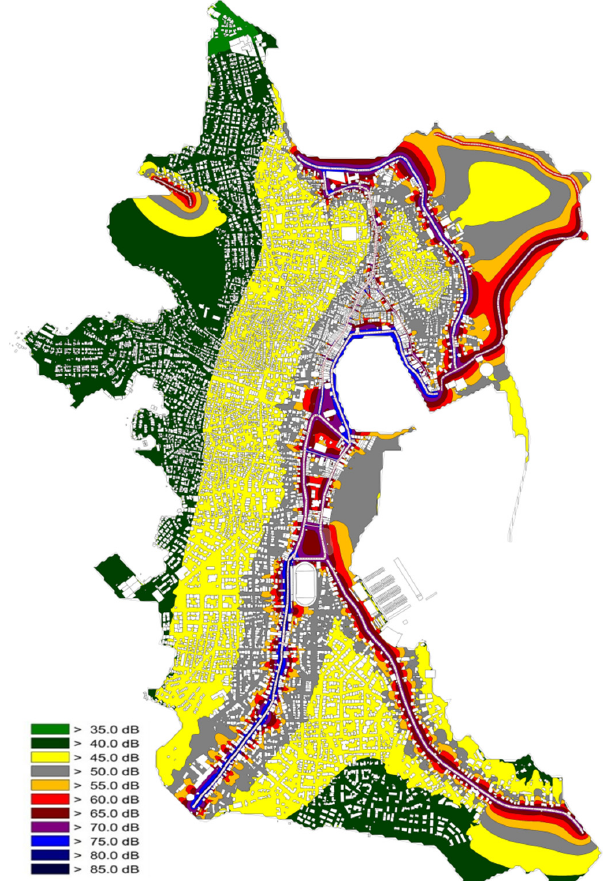
Figure 7. The city’s noise map from the 13 selected roads.